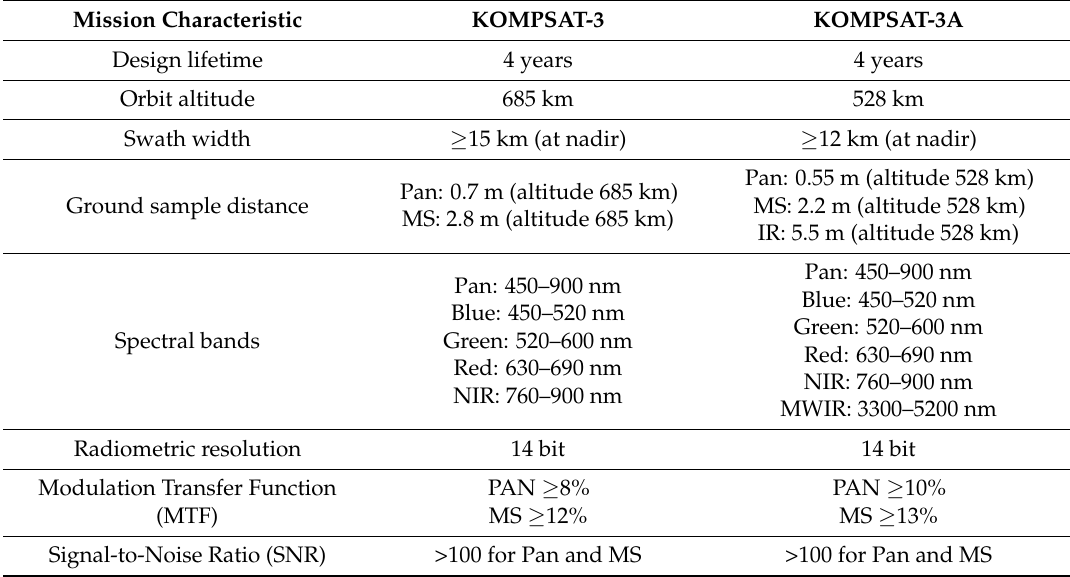
Table 1. Detailed specifications of KOMPSAT-3 and -3A